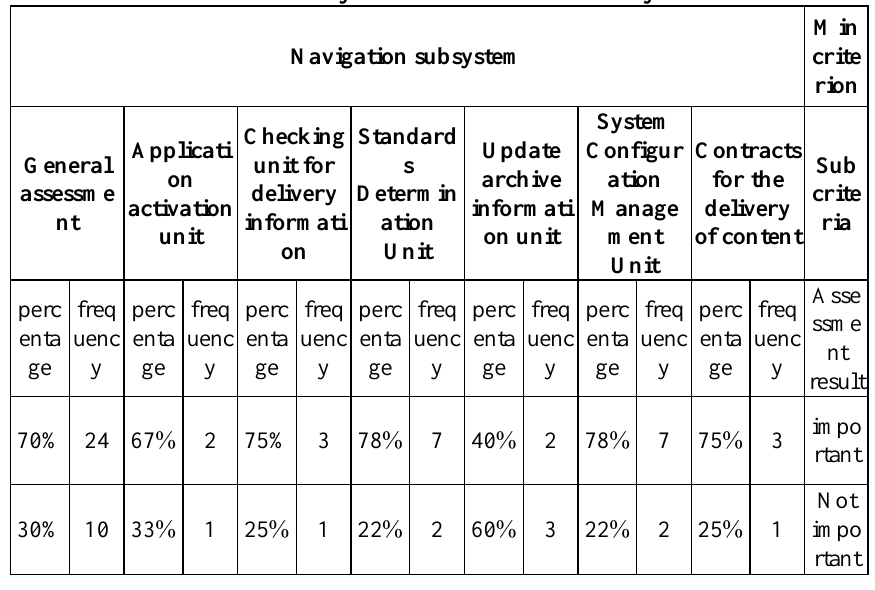
Table 4: Survey of the status of the sub-system